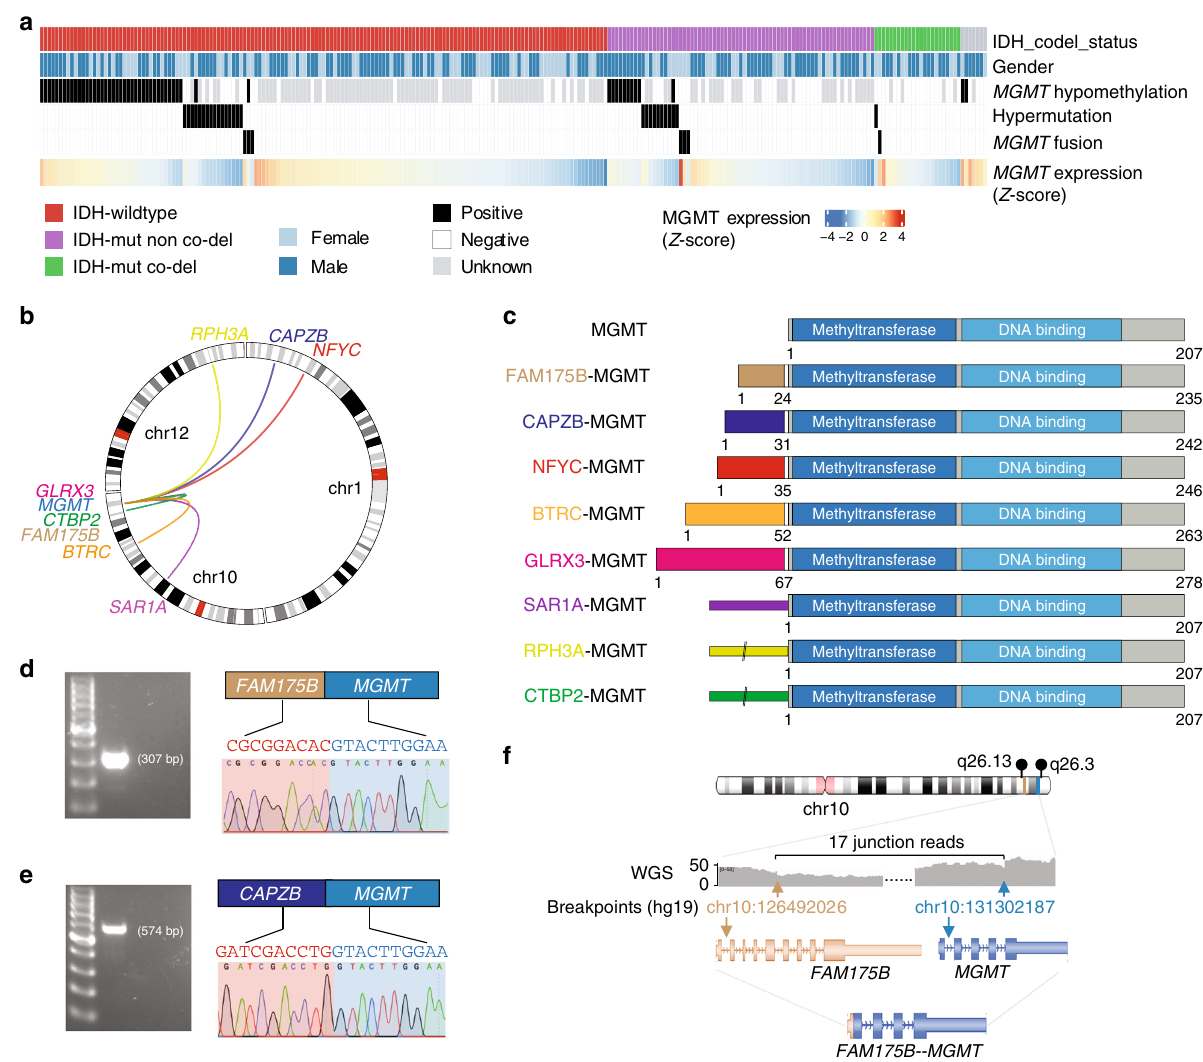
Fig. 1 Multiple MGMT fusions in TMZ-treated recurrent gliomas. a Landscape of MGMT hypomethylation, MGMT fusions, DNA hypermutation. b Circos plot showing the identi fi ed MGMT fusions. c Structure of the MGMT fusion proteins. Each partner gene is indicated by color, and the narrow bars in SAR1A- MGMT, RPH3A-MGMT, and CTBP2-MGMT mean 5 ′ UTR. d , e Validation of the MGMT fusion genes in positive samples by PCR and Sanger sequencing. The bands in the left panel were validated by Sanger sequencing in the right panel. Limited by specimen availability the validation was performed once. f The genomic rearrangement generating FAM175B-MGMT fusion. WGS whole-genome sequencing. Source data are provided as a Source Data